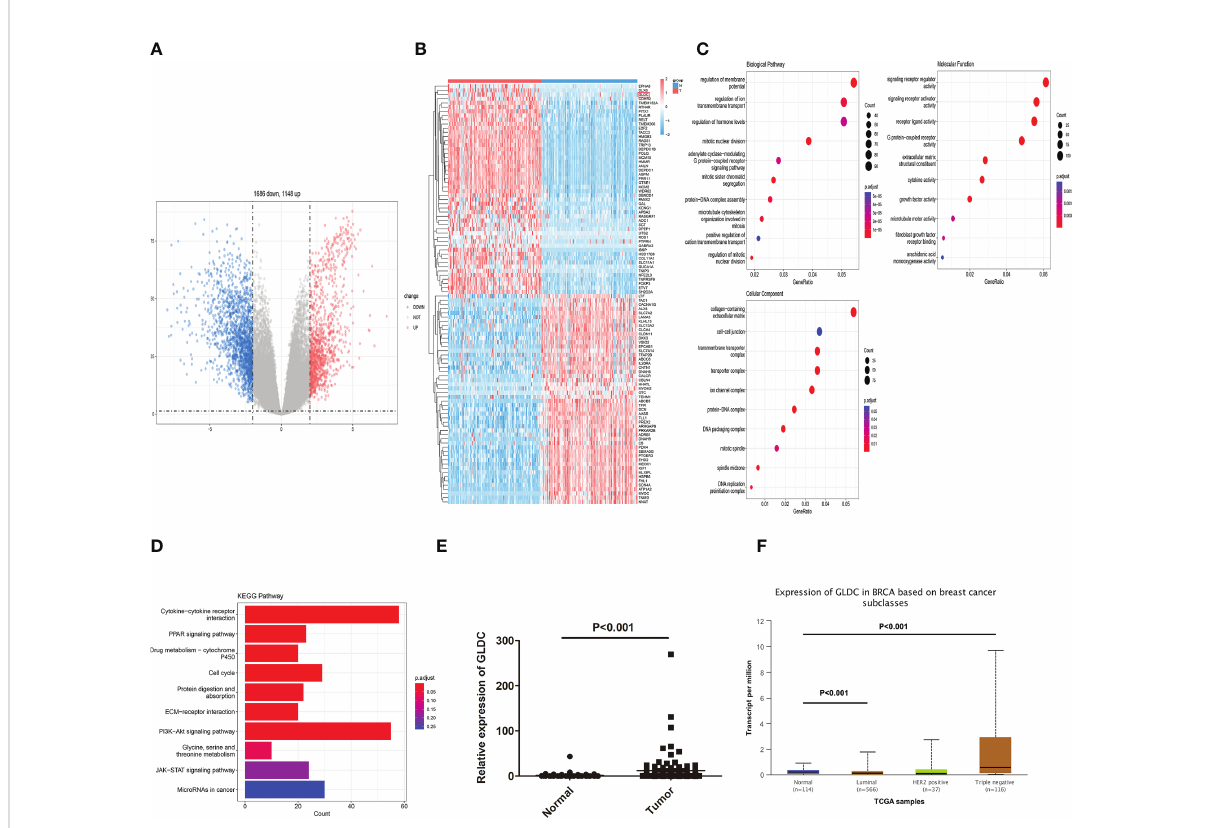
(D) The enriched KEGG pathways. (E, F) The expression of GLDC was signi fi cantly up-regulated in TNBC tissues compared with normal breast tissues by analyzing TCGA (E) and the UALCAN database (F)